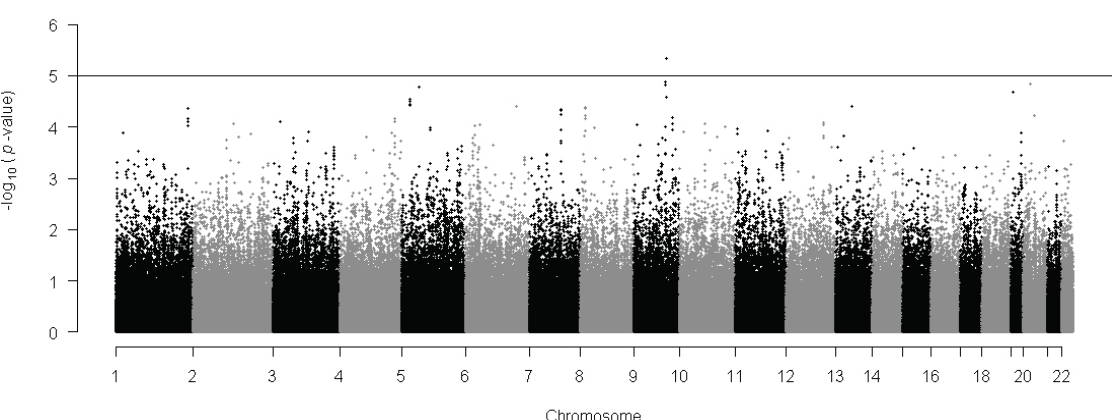
Figure 2. Manhattan plot showing total amount of PA. The horizontal reference line represents the genome-wide association (GWA) threshold p -values 10 − 5 . The p -values from single SNP association test is indicated in − log scale against each chromosome. 10